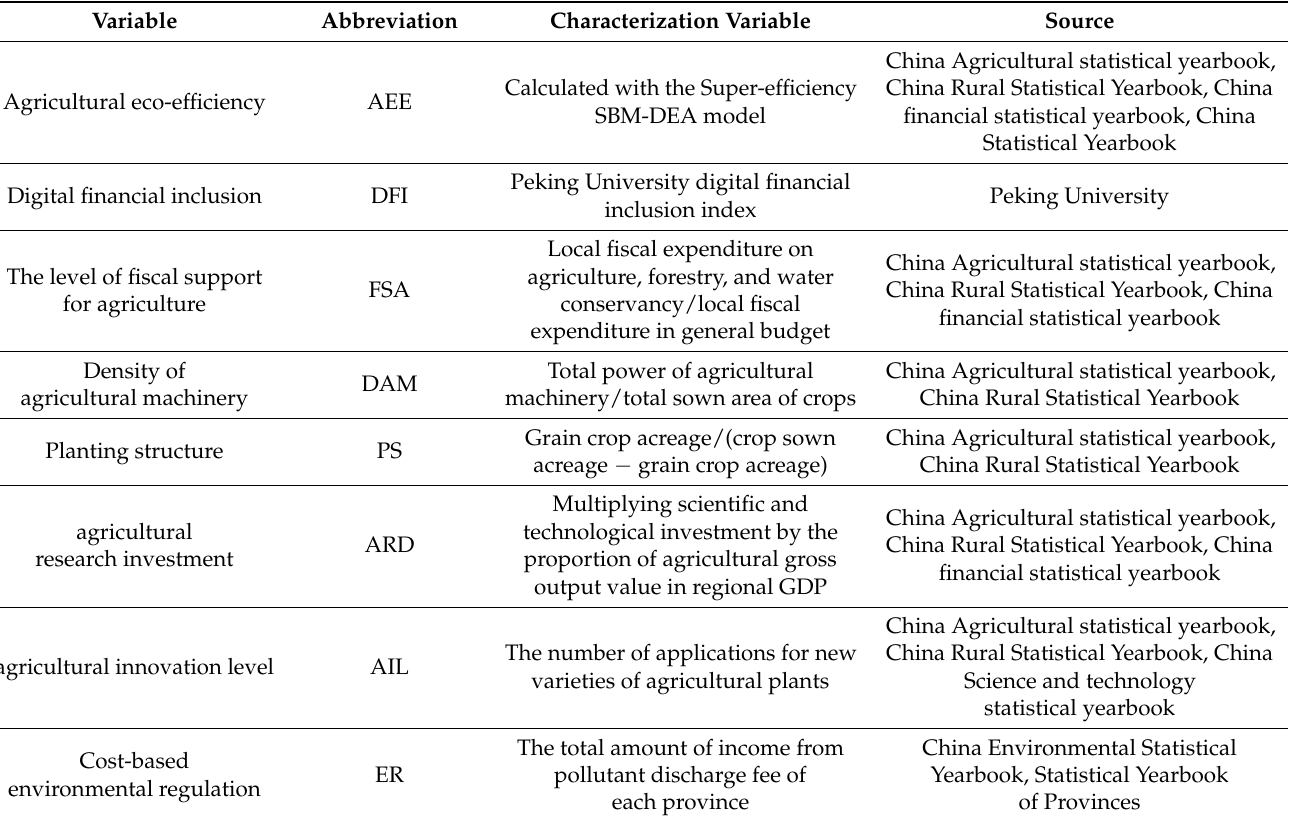
Table 3. Variable characterization and data